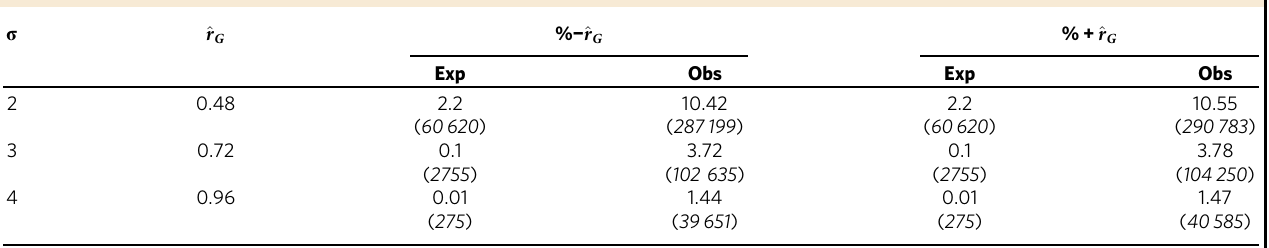
Fig. 4 The number of overlaps between genetically correlated transcript pairs and known regions of interacting chromatin in LCLs and K562 cells. The number of transcript pairs, from the Bonferroni-corrected ( p < 1.81×10 − 8 ) ^ r G subset ( n = 556) or the study-wide FDR of 0.05 subset ( n = 14 991), that overlap known LCL and K562 chromatin interaction sites (500 kb window) are shown by red lines . a shows the intrachromosomal interactions for LCLs (Bonferroni, n = 128; FDR, n = 971), b shows intrachromosomal interactions for K562 cells (Bonferroni, n = 128; FDR, n = 971), and c shows interchromosomal interactions for K562 cells (Bonferroni, n = 428; FDR, n = 14 020). The null distribution represented as a grey histogram was obtained by randomly sampling each dataset 1000 times for each window size Table 2 Proportion of observed transcript pairs at standard deviations ( σ ) de fi ned under null hypothesis (H 0 : ^ r G =